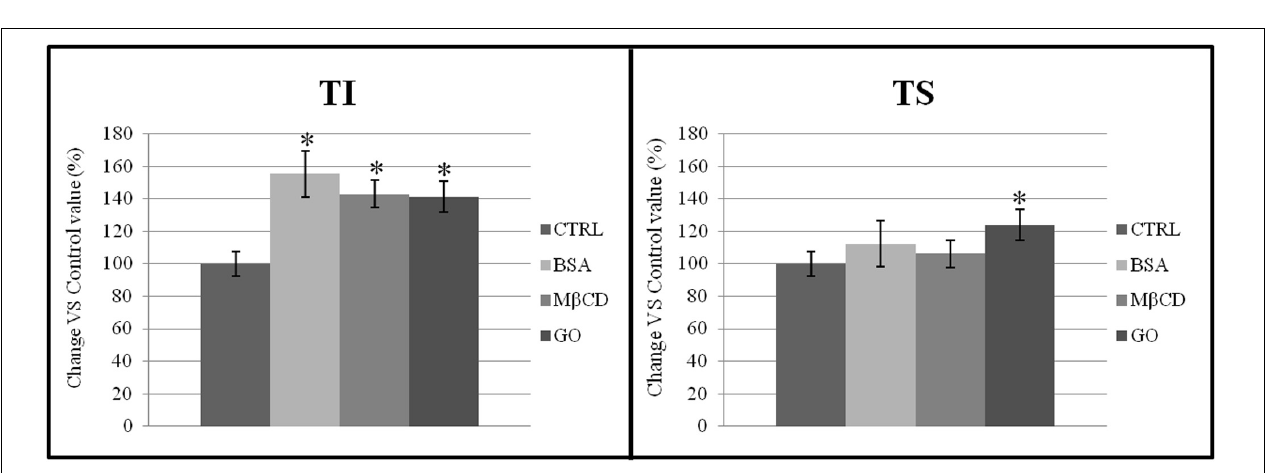
FIGURE 5 | Distribution of Cav-1 between insoluble (TI) and soluble (TS) membrane fractions, isolated from MEF prepared from sperm incubated in a capacitating medium (BSA, MBCD, GO treatments), or from sperm collected in a non-capacitating medium (CTRL). The data reported were expressed as cav-1 abundance in each group. Values are means ± SE for three separate experiments. * P < 0.05 versus control.